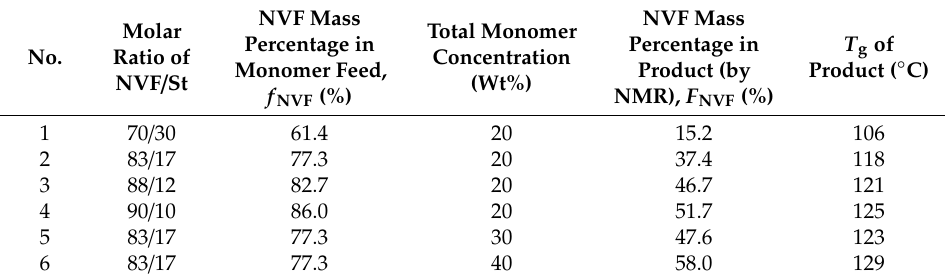
Table 1. Composition and T g of N -vinylformamide (NVF-St) copolymers *.